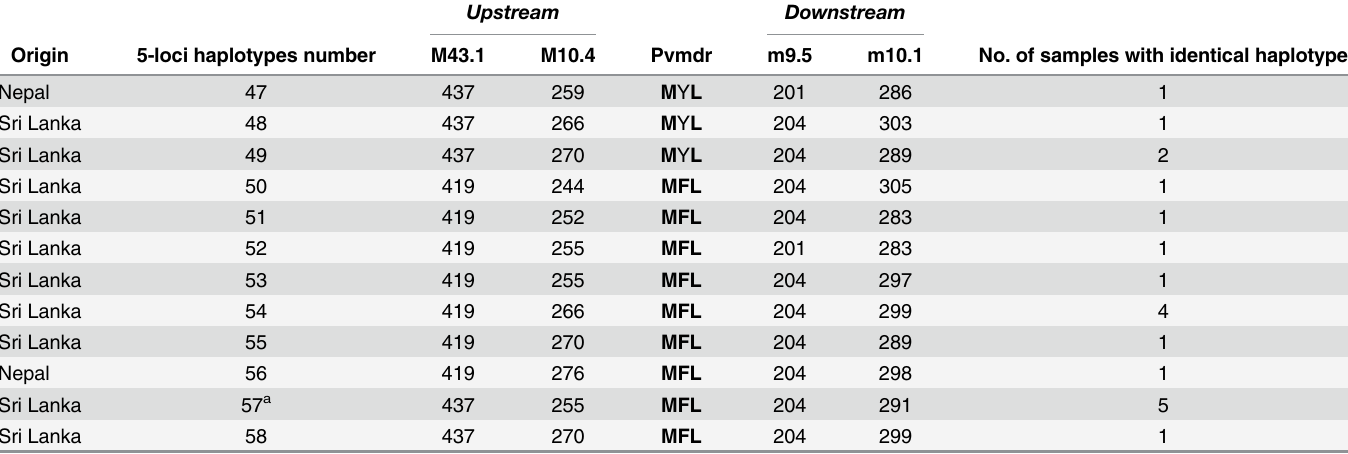
The samples from Ecuador (n = 13), Nepal (n = 16), Pakistan (n = 3), Sri Lanka (n = 58) and Sudan (n = 2) a shown together with Sal-1 which is a wild- type chloroquine sensitive haplotype (GenBank accession number AY571984.1). The number of samples per geographical origin, which possessed each distinct haplotype are shown in the last column where there was more than one the row is highlighted dark gray: Excluded in the table are all the polyclonal samples. a 5-loci haplotypes calculated to be in signi fi cantly linkage disequilibrium (D` = 1, P < 0.0001). b A sample from Nepal contained two further mutations at c979 (F979S, TTT ! TCT) and c980 (M980V, ATG ! GTG). c This sample from Nepal was also mutated at c1080 (S1080N, AGT !